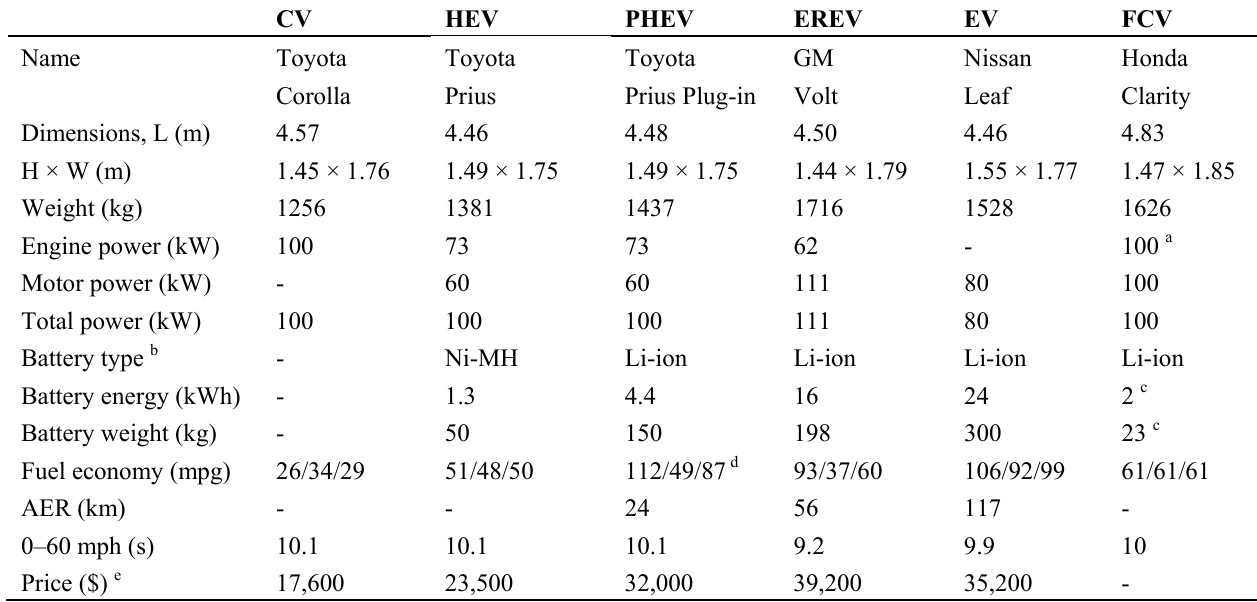
Table 1. Characteristics of conventional vehicle and advanced